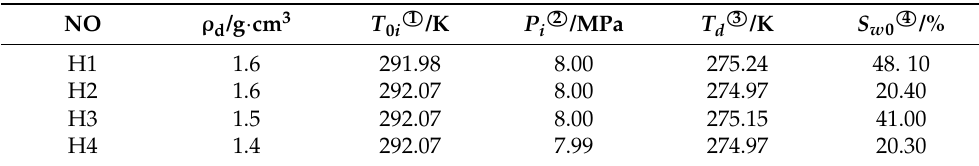
Table 2. Detailed information of tests.